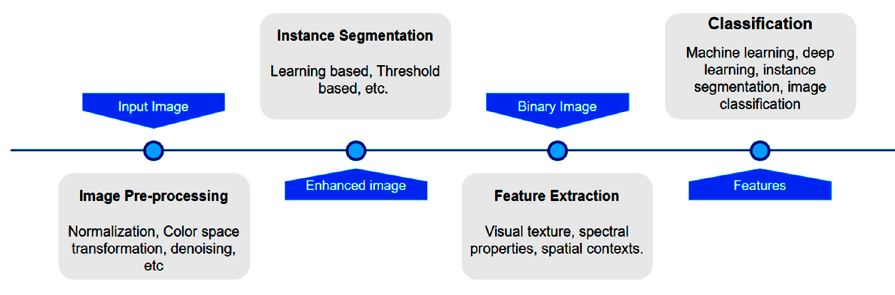
Figure 4. General workflow of the image pre ‐ processing process for image classification .